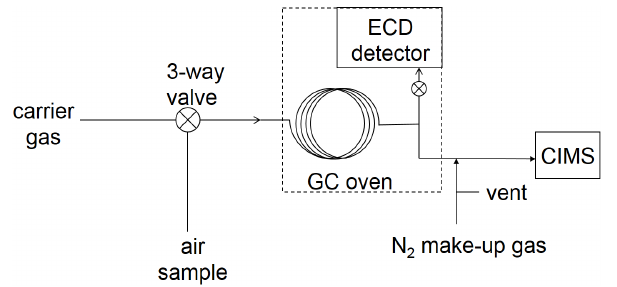
Figure 1. GC-ECD/CIMS setup for the CIMS sensitivity of 1,2-IN relative to 4,3-IN.